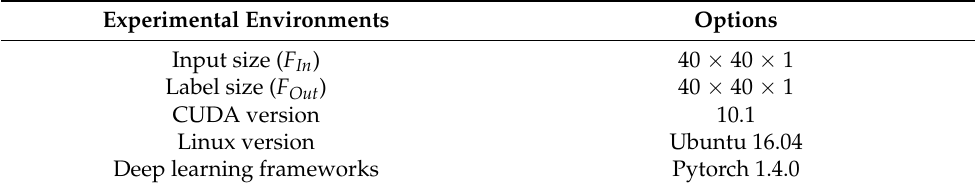
Table 7. SSIM comparisons on the test datasets. The best results of dataset are shown in bold. Dataset